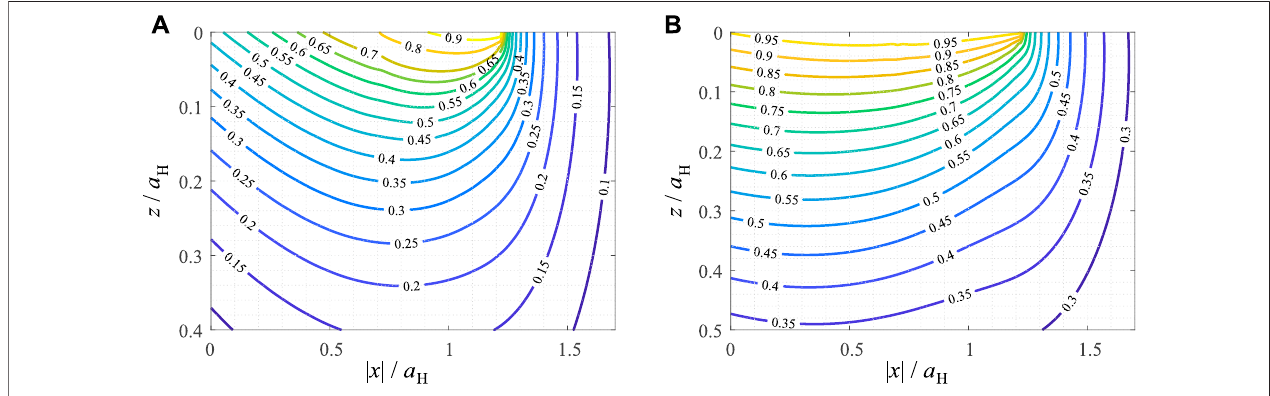
FIGURE 5 | Contour line diagrams of critical plane fatigue crack initiation criteria, normalized for their maximum values, in the loading plane for the axisymmetric partial slip limiting wear pro fi le under oscillating tangential load. (A) Smith-Watson-Topper parameter (B) Findley parameter.